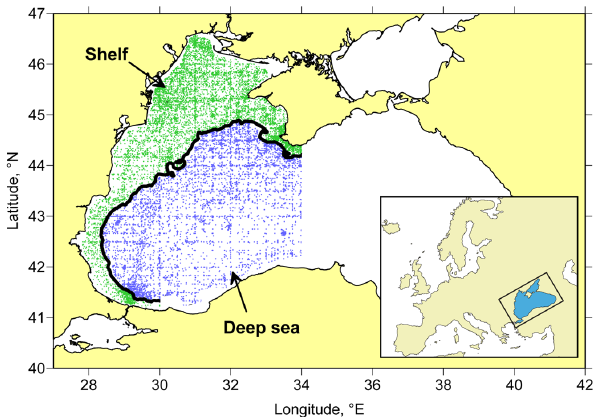
Fig. 1. Location map of the Black Sea and the boundaries of the shelf and deep sea compartments (separated by the 150m isobath shown in bold). Also shown are the locations of stations in the com- bined WOD+ROM+MHI data set used for calculation of inter- annual variability for 1950–2004 in the shelf compartment (green, 27016 stations) and the deep sea compartment (blue, 11710 sta-